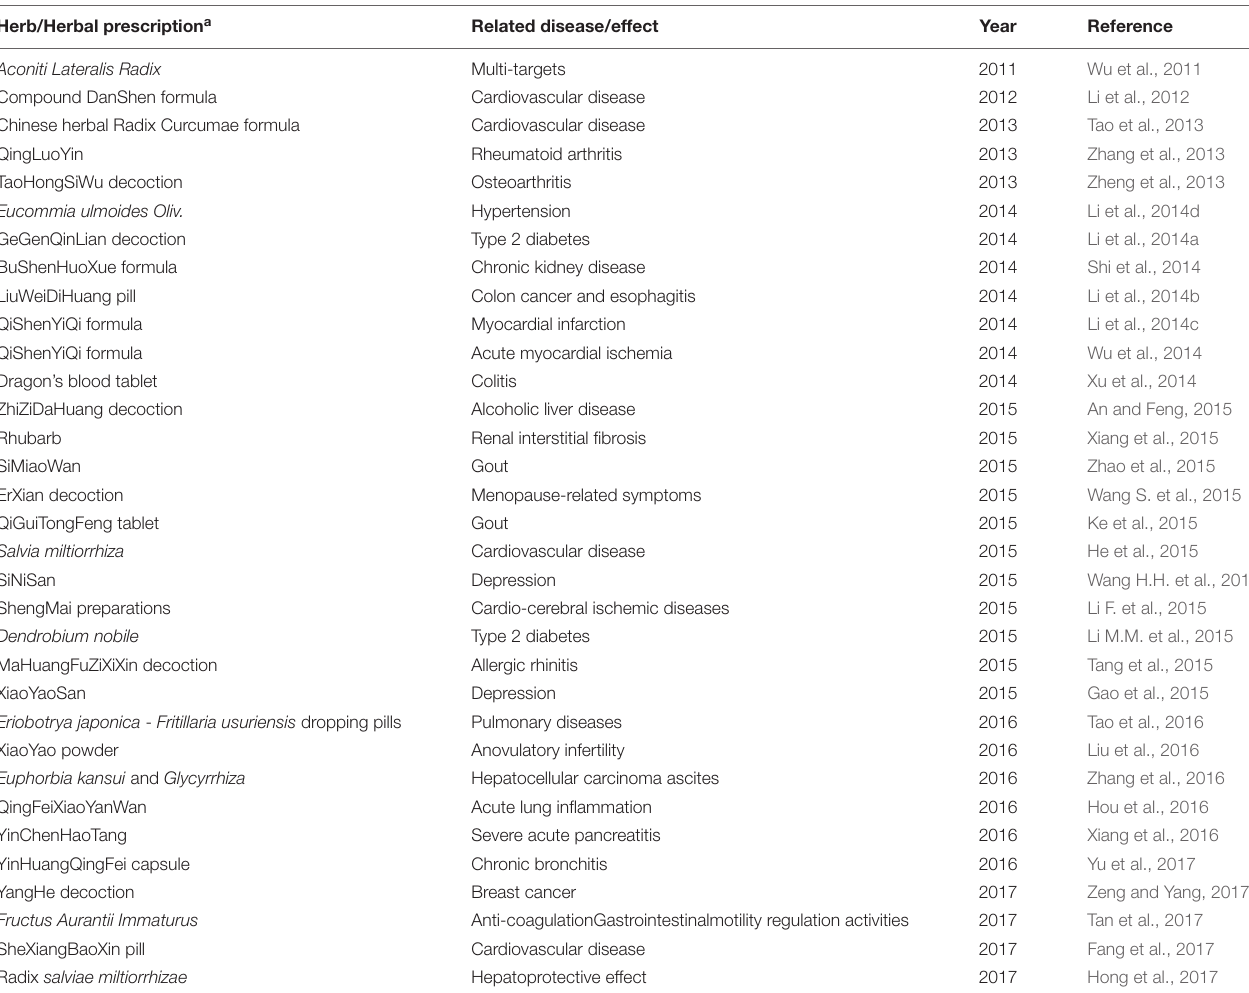
a The biological ingredients of herbal prescription were listed in Supplementary Table S1 .